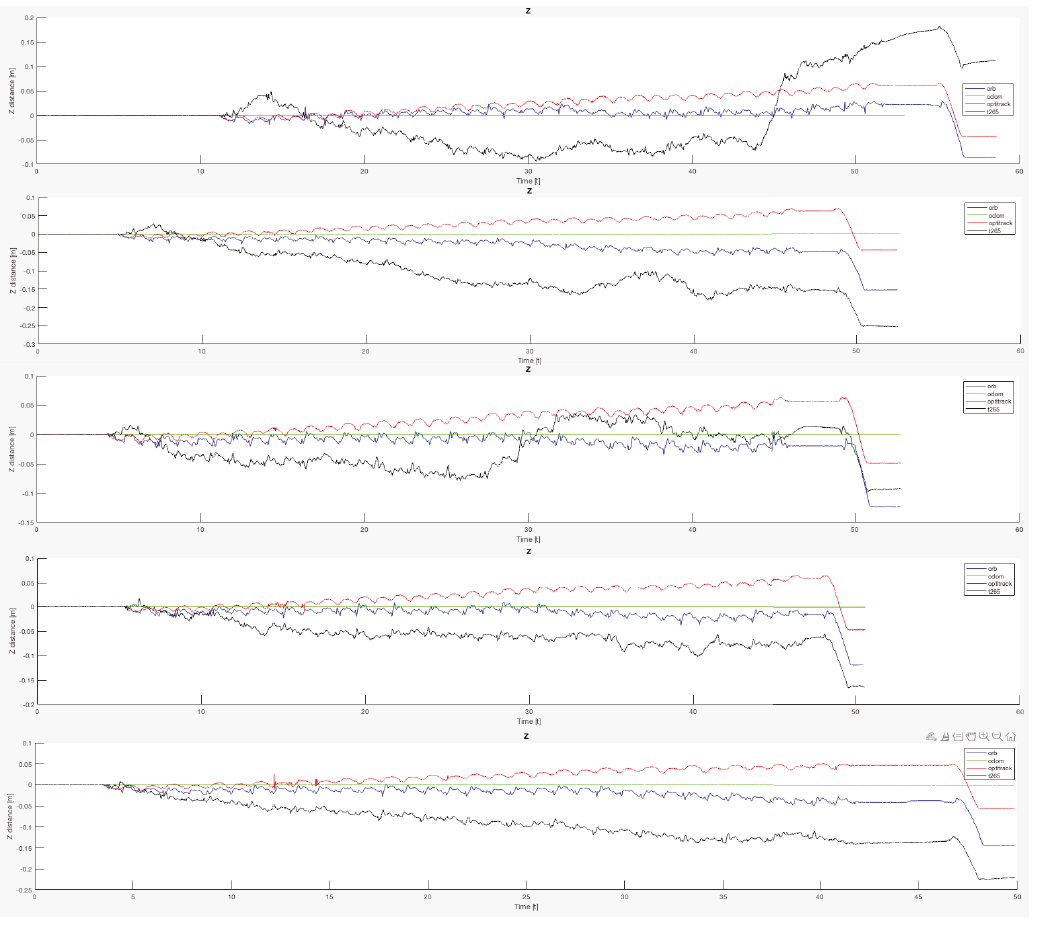
Figure 21. Indoor tests scenario 2. Test 1. Trials 1–5. Error in Z position.